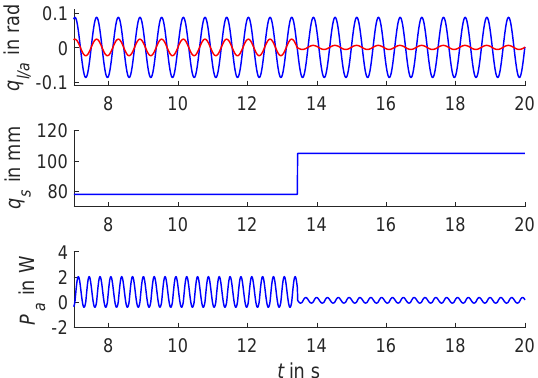
Figure 6. Simulation of adjustment to antiresonance while tracking a sinusoidal trajectory with 1.6Hz; link (blue) and actuator (red) positions in upper plot, counter bearing positions middle plot, mechanical power in lower plot.